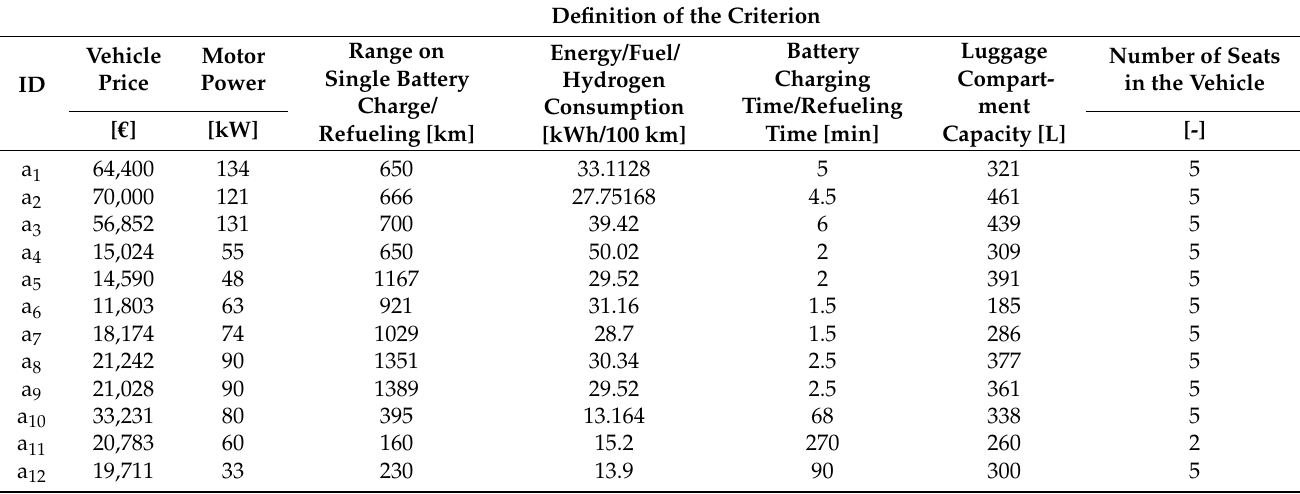
Table 4. Adopted values for particular